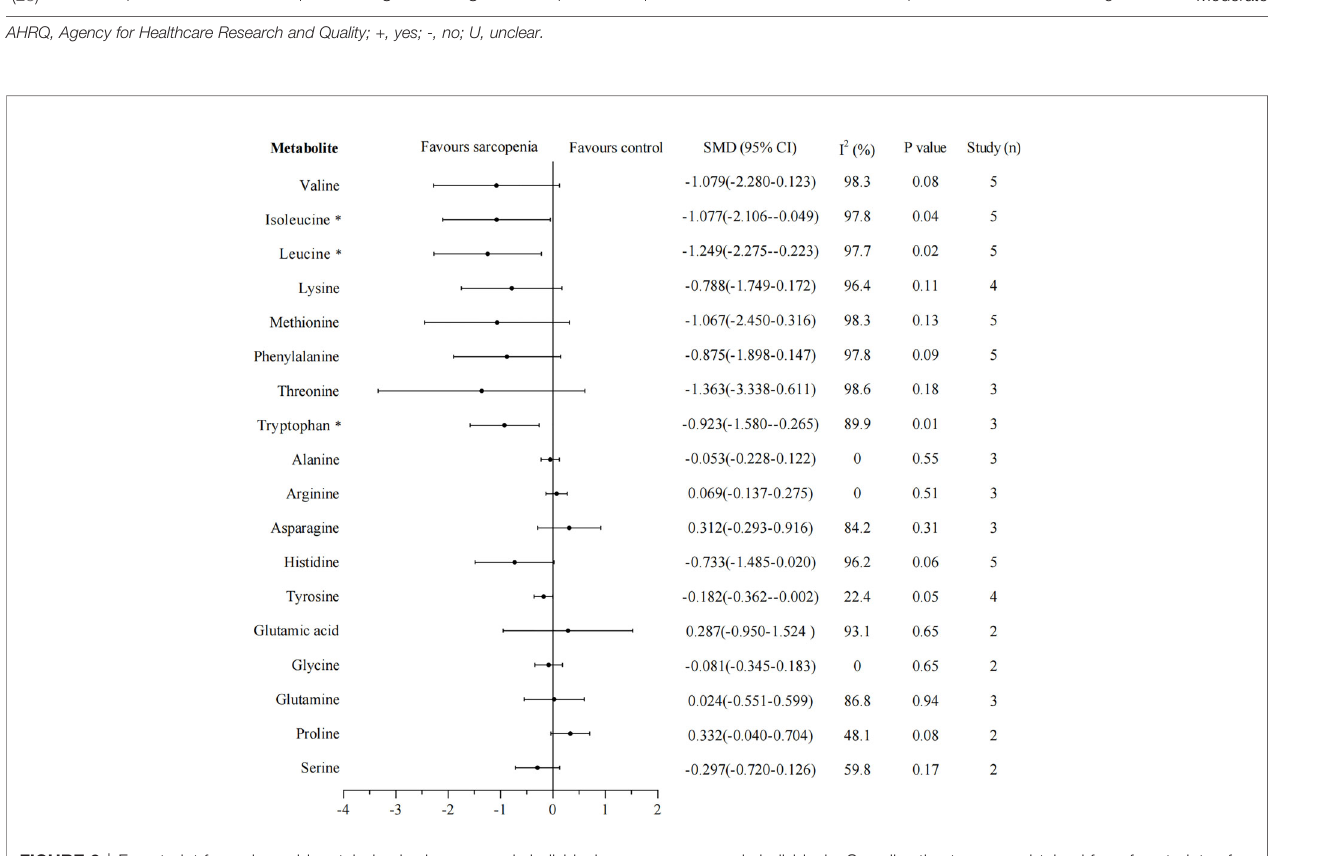
FIGURE 2 | Forest plot for amino acid metabolomics in sarcopenic individuals vs . non-sarcopenic individuals. Overall estimates were obtained from forest plots of the meta-analysis using the random-effects model. Closed circles and horizontal bars represent the overall estimate and 95% CI. SMD, standardized mean difference; CI, con fi dence interval. Asterisks (*) indicate P-value